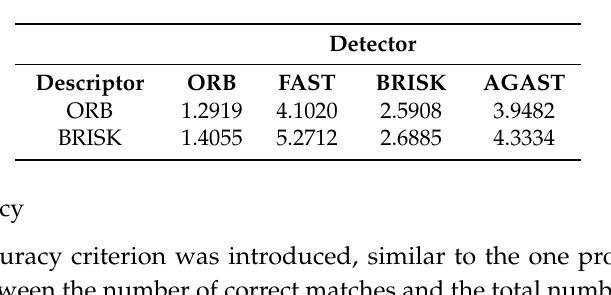
Table 2. Processor time for different combination pairs.